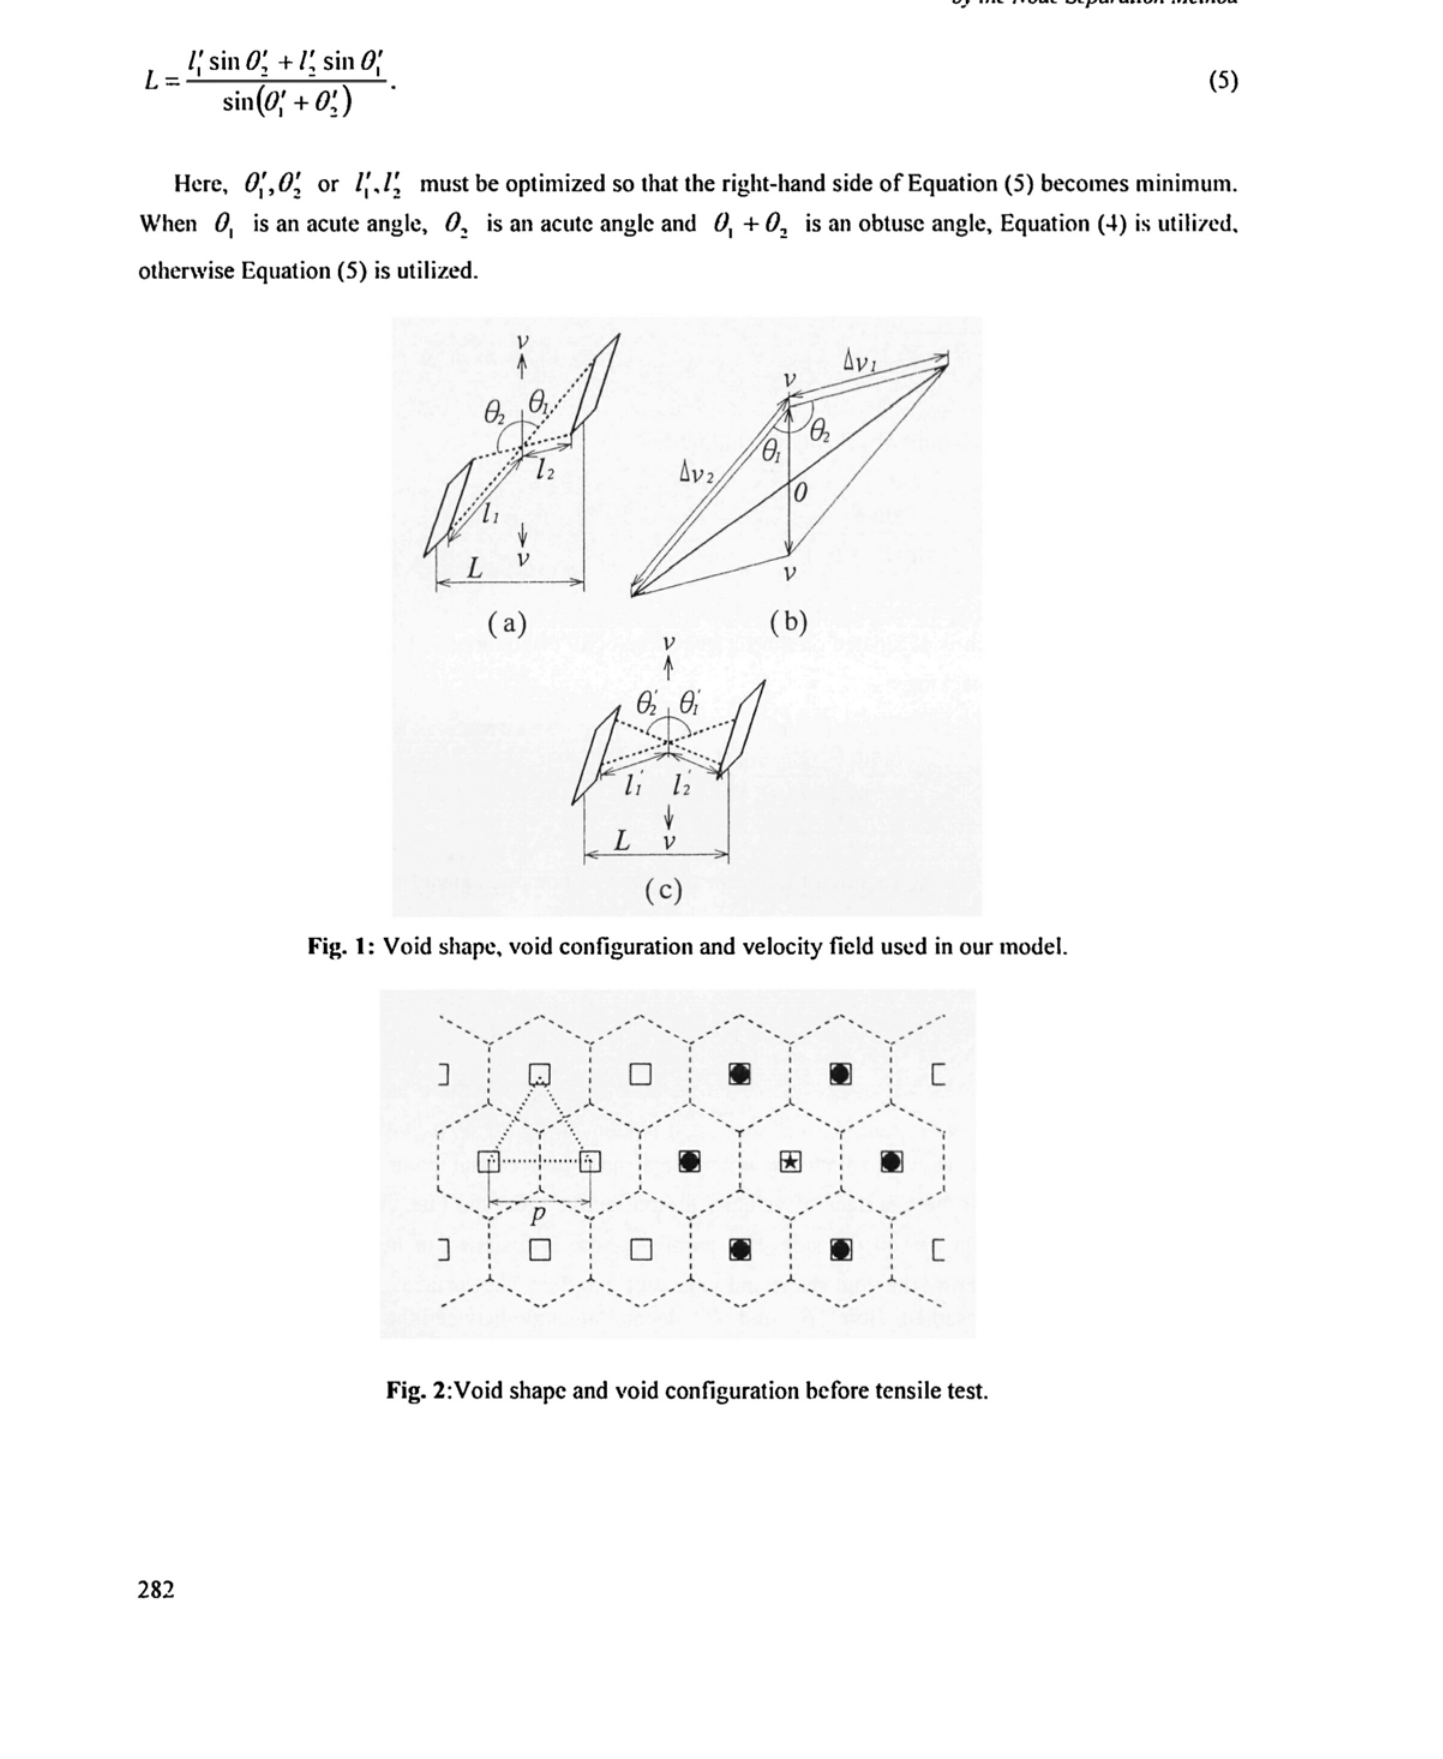
Fig. 1: Void shape, void configuration and velocity field used in our model.